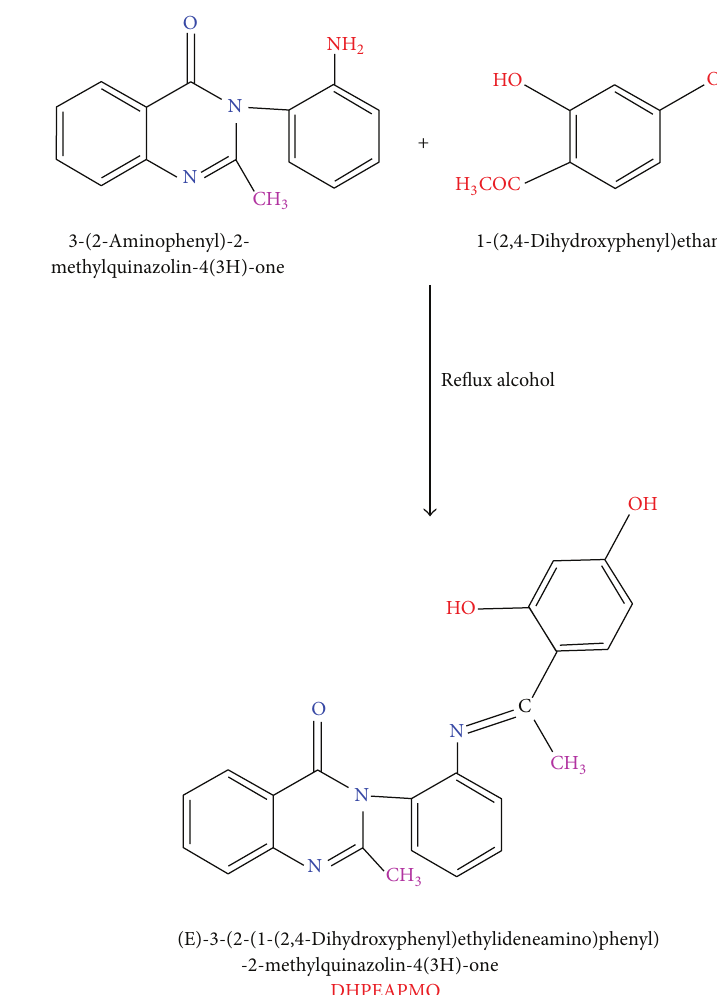
Scheme 1: Synthetic route for the preparation of